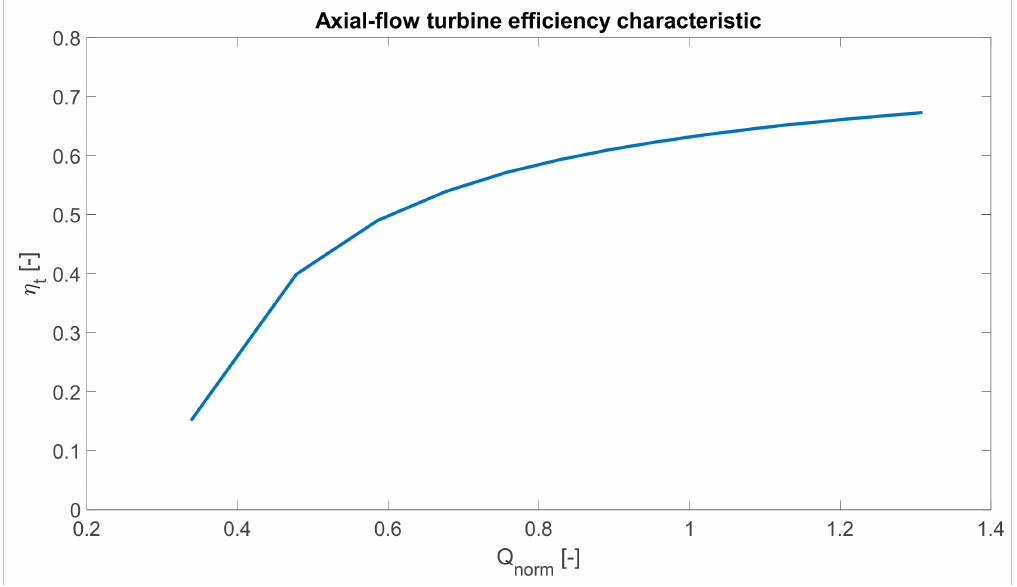
Figure 6. Turbine efficiency characteristic as function of the normalized flow